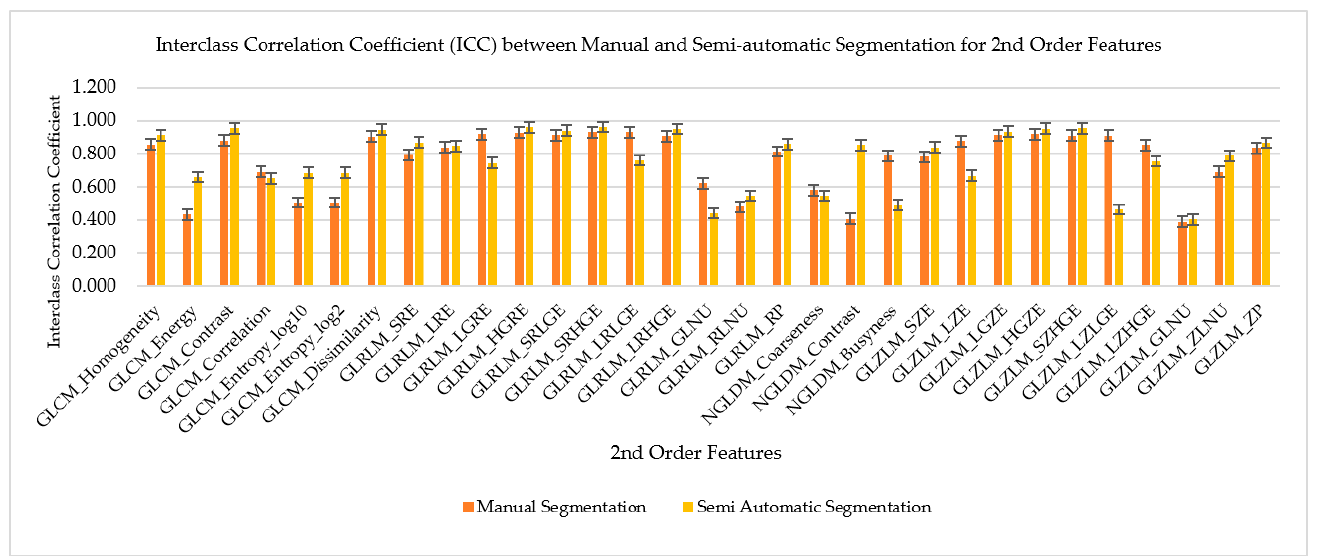
Figure 8. Interclass Correlation Coefficient (inter-CC) between manual and semi-automatic segmen- tation for 2nd order features to compare its reproducibility.